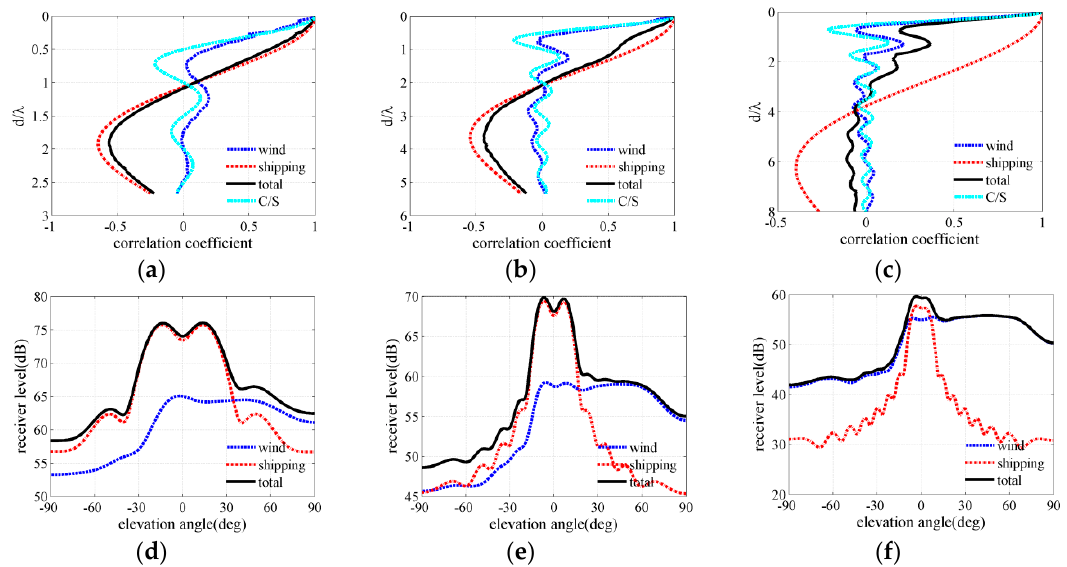
Figure 5. Vertical correlation and directionality at wind speed of 7 m/s for frequencies of ( a , d ) 50 Hz ( b , e ) 100 Hz and ( c , f ) 150 Hz.